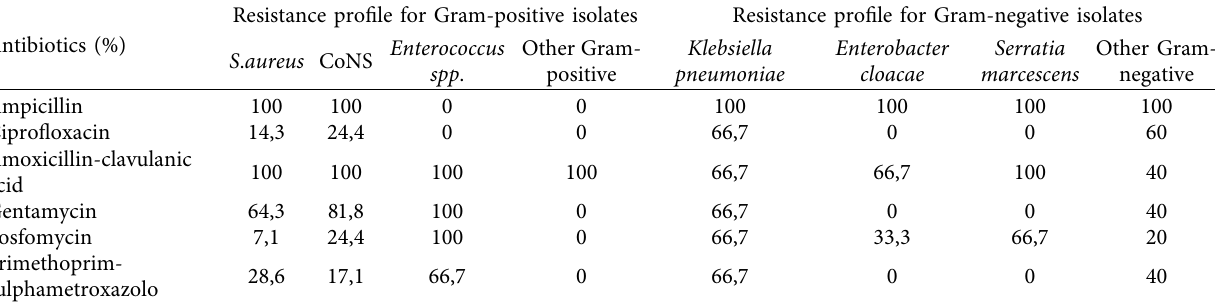
Table 6: Resistance rates of Gram-positive and Gram-negative isolates for common tested antibiotics.